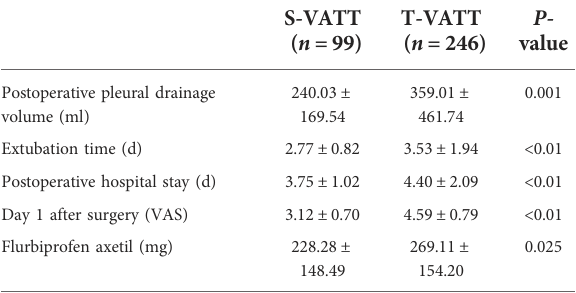
TABLE 4 Comparison of postoperative indicators between the two